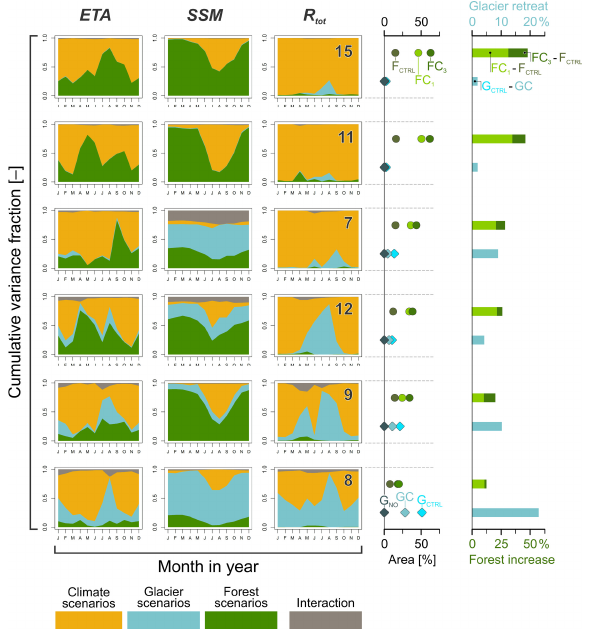
Fig. 7. ANOVA for the annual cycles of monthly change values per target variable ETA, SSM, R tot . Each column shows the ANOVA re- sults for one target variable and each row of three panels represents the results per catchment. The catchment number is indicated in the upper right corner of the respective right panel. The catchments are sorted from top to bottom according to decreasing forest change and increasing glacier retreat (except for catchments 7 and 12 where the order is twisted with respect to the glacier). The forest and glacier extents in percent catchment area are given for every catchment on the right side as well as the respective forest and glacier